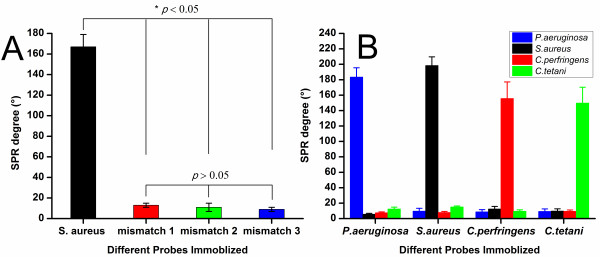
Specificity of the detection with SPR biosensor. A) Hybridization of PCR products of S. aureus. A total of 50 nM of the PCR products of S. aureus were incubated with four different probes: a specific probe (black column), a 5'-end single-base mismatch probe (red column); a middle single-base mismatch probe (green column); a 3'-end single-base mismatch probe (blue column). * P < 0.05 vs other three single-base mismatch probes. B) Hybridization of a mixture of PCR products from four bacteria with four specific probes.